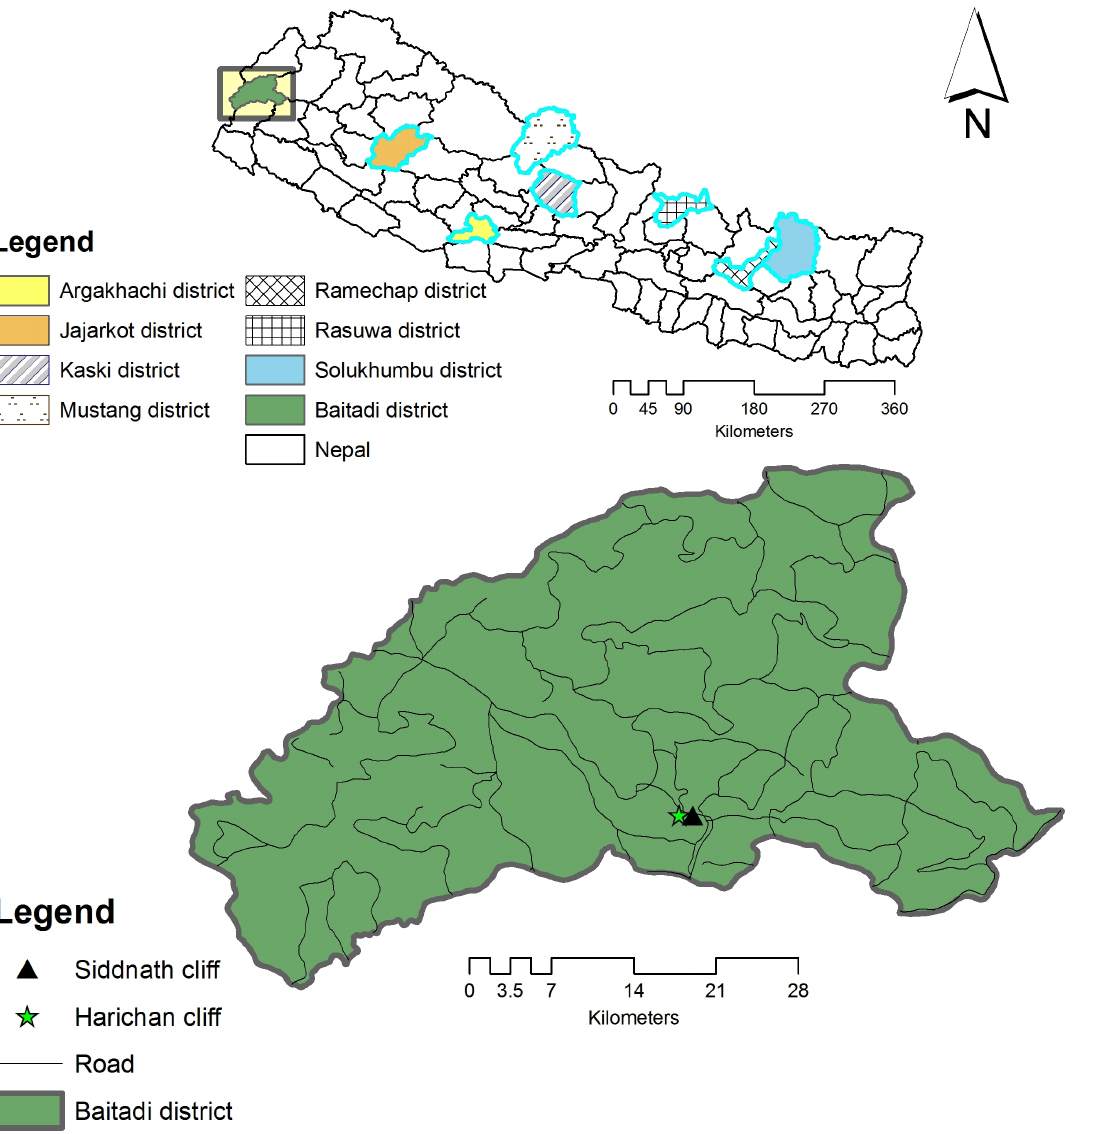
Figure 1. Study area showing two cliffs at Baitadi District (Khodpe), Far-west Nepal and other districts where Himalayan Vultures were studied after 2000: Baitadi District (Karmachaya 2011), Argakhachi District (Bhusal 2011), Jajarkot District (Bhusal 2014), Kaski District (Gurung et al. 2004; Tyabji 2006; Subedi et al. 2013), Mustang District (Virani et al. 2008; Acharya et al. 2009; Paudel et al. 2015), Ramechap District (Phuyal 2012), Rasuwa District (Baral et al. 2002) and Solukhumbu District (Baral et al.